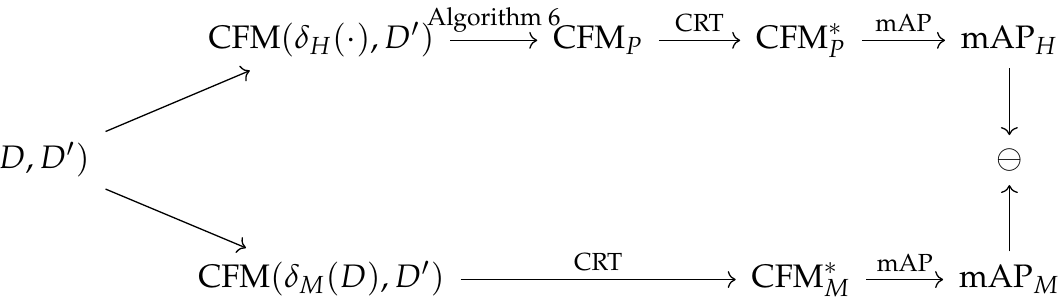
Figure 5. The data processing diagram of user population re-targeting. Dataset is denoted by D its ) , D (cid:48) ) subset is denoted by D (cid:48) , confusion matrix computed from human results is denoted by CFM ( δ H ( · and confusion matrix computed from machine classification is denoted by CFM ( δ M ( D ) , D (cid:48) ) . CFM P represents population confusion matrix, CFM ∗ denotes population confusion matrix transformed P by CRT operations, CFM ∗ is a transformed machine confusion matrix, mAP denotes mean average M precision metric, and the comparison of metrics is denoted by (cid:9)